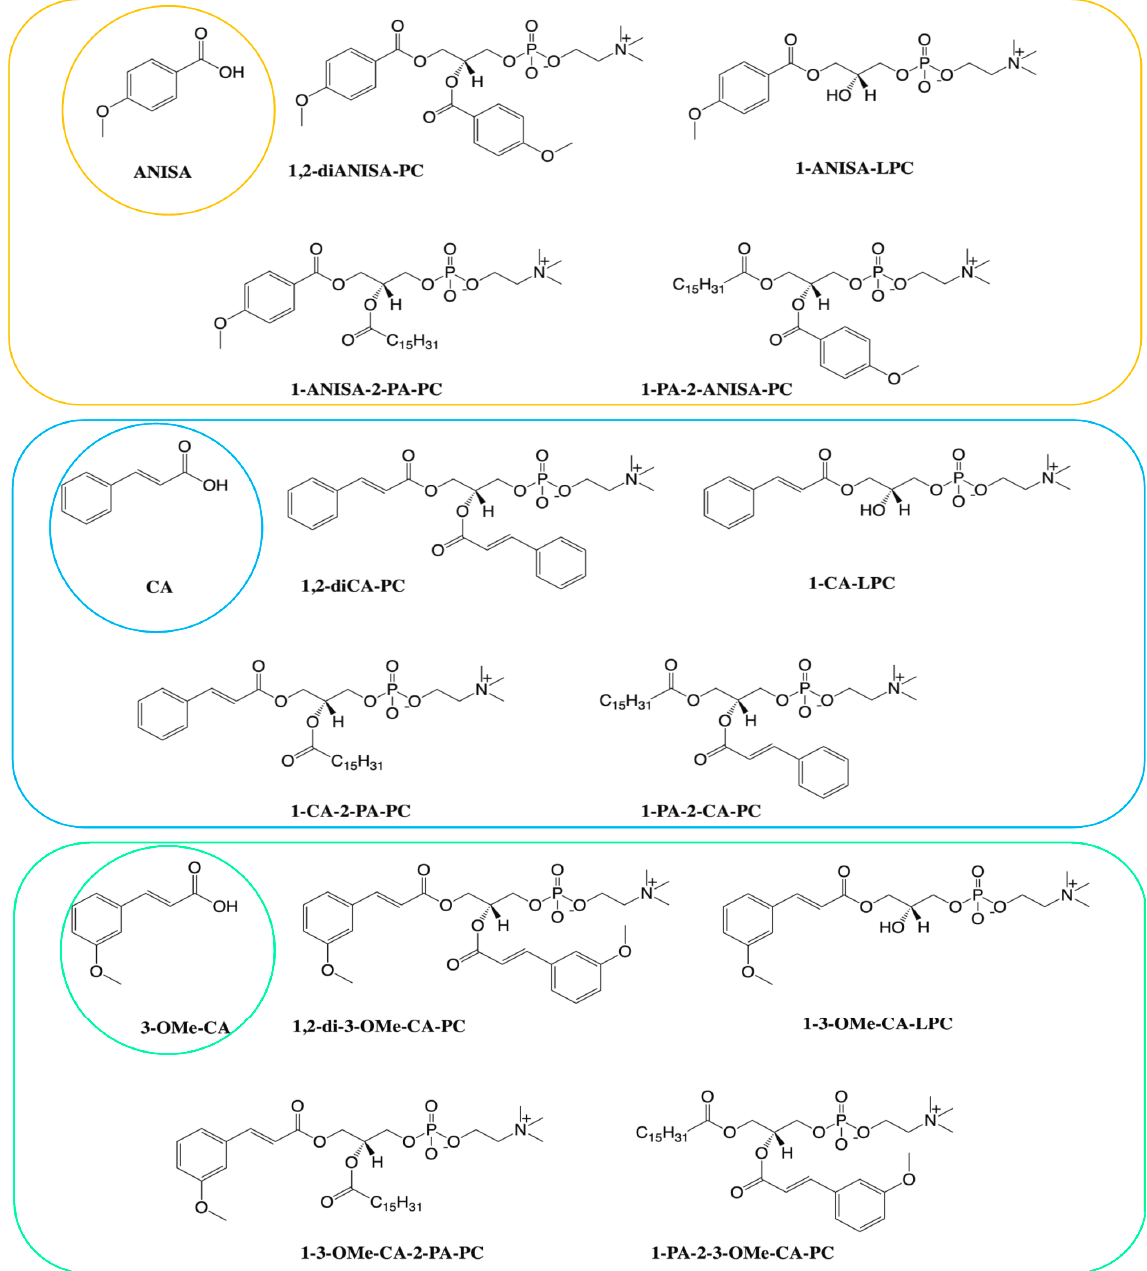
Figure 1. Studied conjugates of phospholipids and aromatic acids: p -anisic acid (ANISA), 1,2-dianisoyl- sn -glycero-3-phosphocholine (1-diANISA-PC), 1-palmitoyl-2-anisoyl- sn -glycero-3-phosphocholine (1-PA-2-ANISA-PC), 1-anisoyl-2-palmitoyl- sn -glycero-3-phosphocholine (1-ANISA-2-PA-PC), cinnamic acid (CA), 1,2-dicinnamoyl- sn -glycero- 3-phosphocholine (1,2-diCA-PC), 1-palmitoyl-2-cinnamoyl- sn -glycero-3-phosphocholine (1-PA-2-CA-PC), 1-cinnamoyl- 2-palmitoyl- sn -glycero-3-phosphocholine (1-CA-2-PA-PC), 3-methoxycinnamic acid (CA), 1,2-di(3-methoxycinnamoyl)- sn -glycero-3-phosphocholine (1,2-di-3-OMe-CA-PC), 1-palmitoyl-2-(3-methoxycinnamoyl)- sn -glycero-3-phosphocholine (1-PA-2-3OMe-CA-PC), 1-(3-methoxycinnamoyl)-2-palmitoyl- sn -glycero-3-phosphocholine